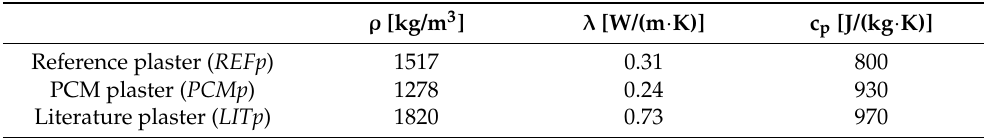
Table 7. Thermal properties of the plasters used in the simulations.